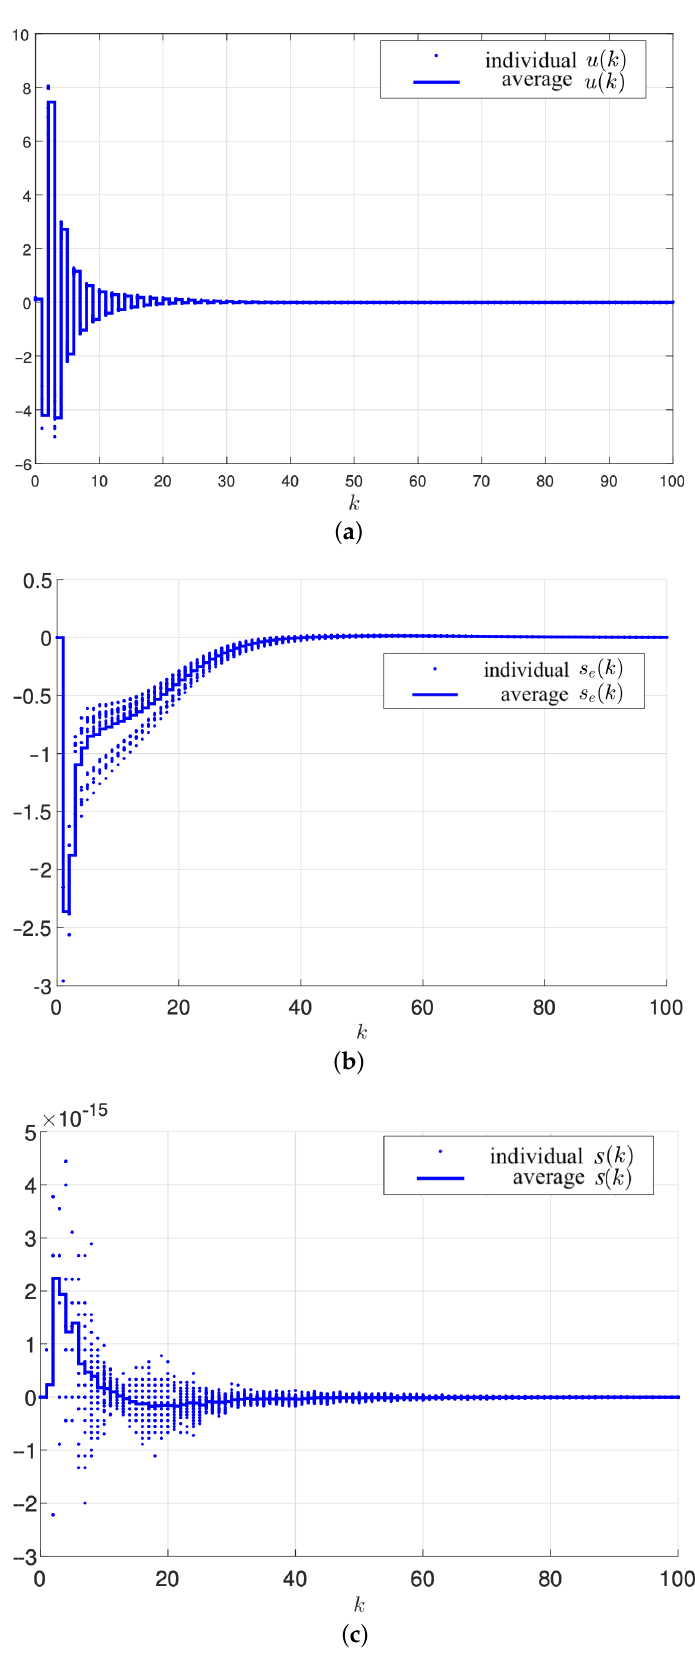
Figure 3. Input trajectories ( a ), trajectory of s e ( k ) ( b ), and trajectory of s ( k ) ( c